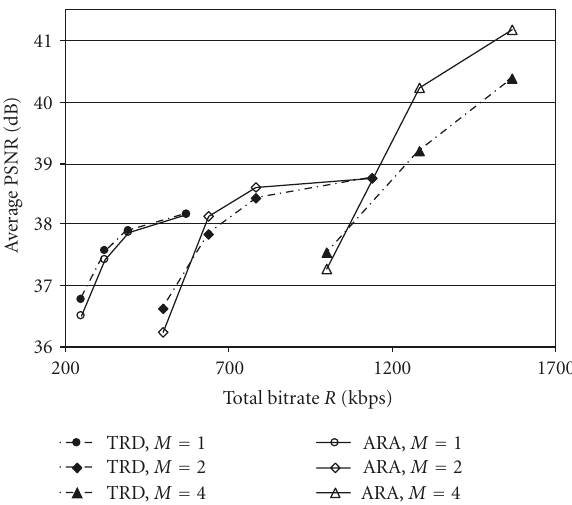
Figure 5: R-D curves obtained with a TRD system and with the ARA